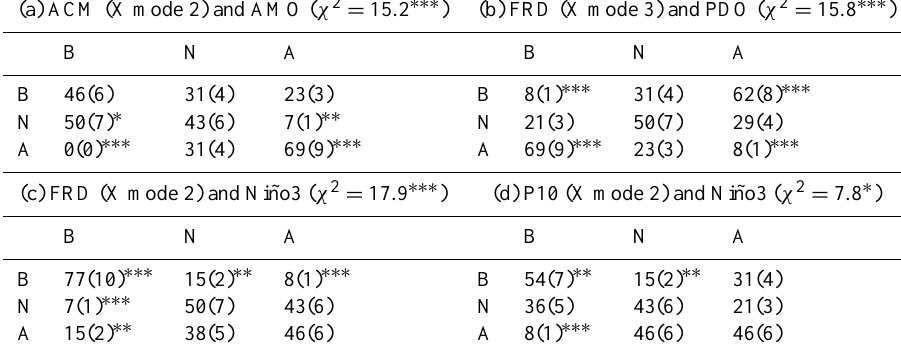
Table 3. Relative frequency (%) contingency tables between higher order modes of July SST of each model (X modes, red lines in Fig. 7) and some SST indexes. In parentheses are the absolute frequency values. Categories are Below (B), Normal (N) and Above (A). Levels of significance are represented by ∗∗∗ > 99% ( α < 1%), ∗∗ 95–99% (1 <α < 5%) and ∗ 90–95% (5 <α <